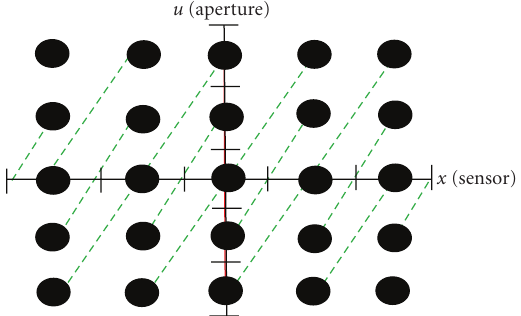
Figure 4: The lines used in the SDFST for a particular